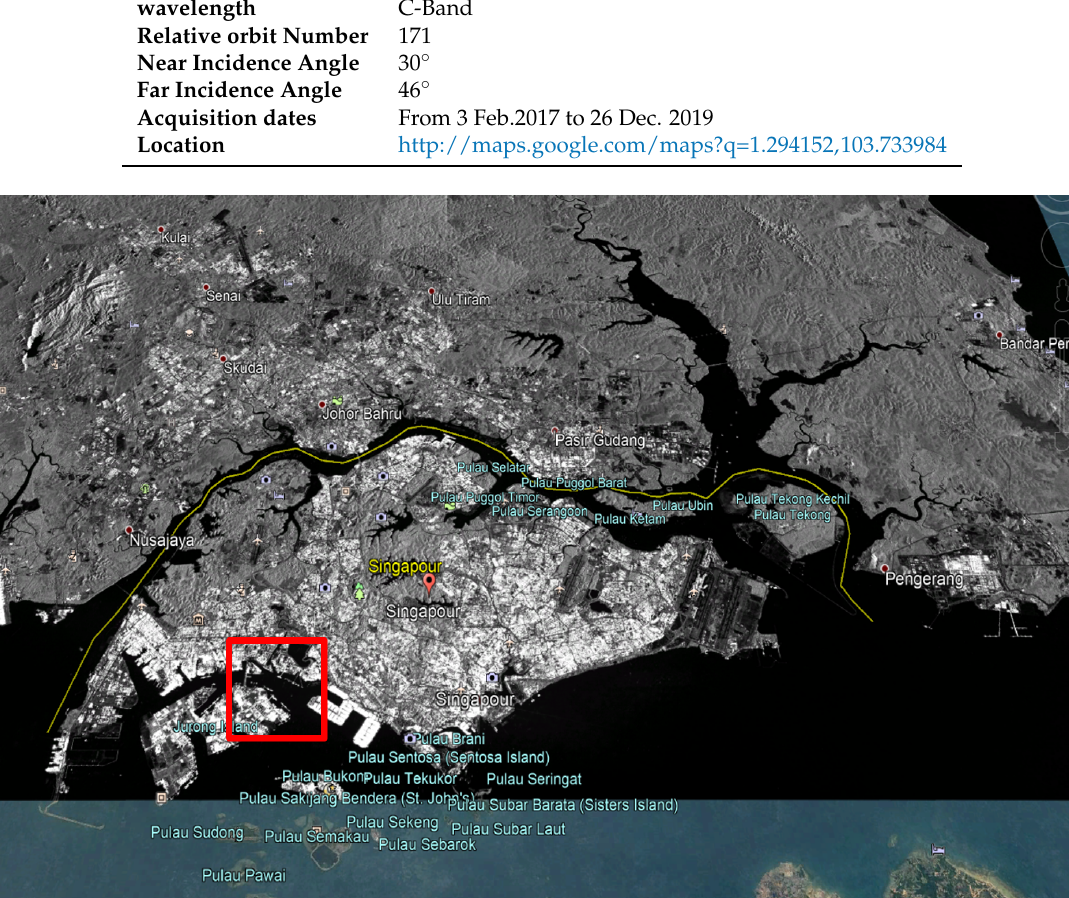
Figure 14. FBR image Projected on Google Maps (study area within the red